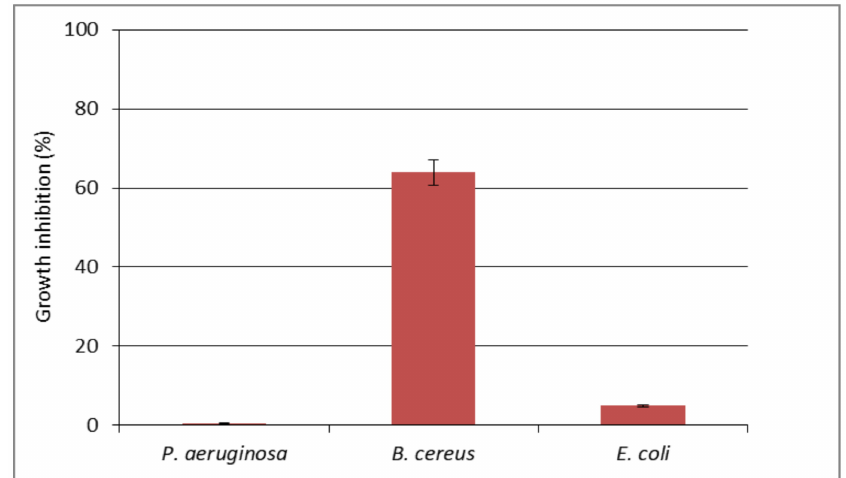
Figure5. Thee ff ectof[Zn(BT)(NO 3 ) 2 ]onthegrowthofmodelbacteriaandyeaststestedinmeat-peptone broth (MPB). K, microbial growth in MPB without added compound.